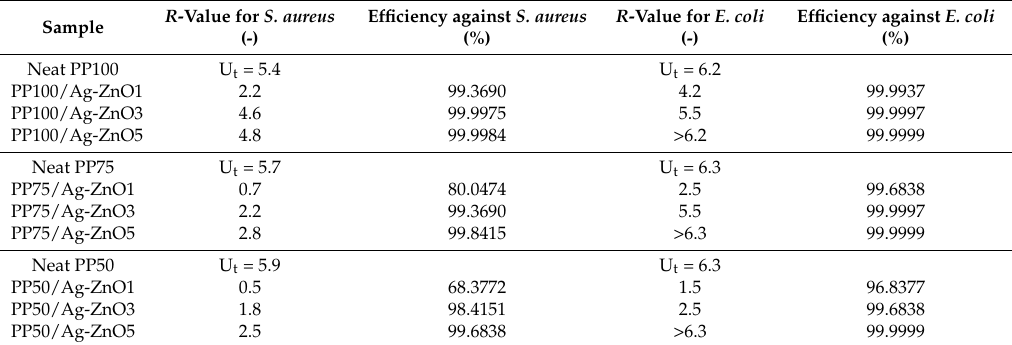
Table 4. Evaluation of surface antibacterial activity of Ag-ZnO polymer nanocomposites according to ISO 22196:2007 (E) [42]. R -Value for S. aureus Sample